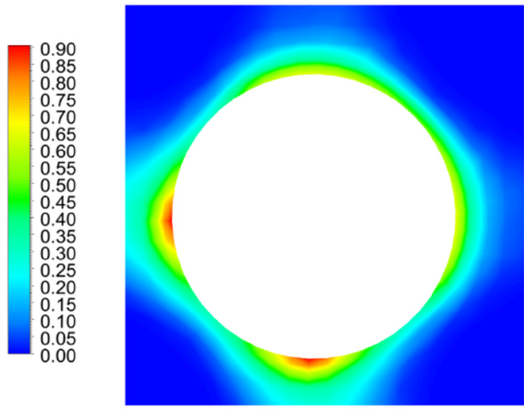
Table 6. Comparison of experimental data and predicted DNB data.